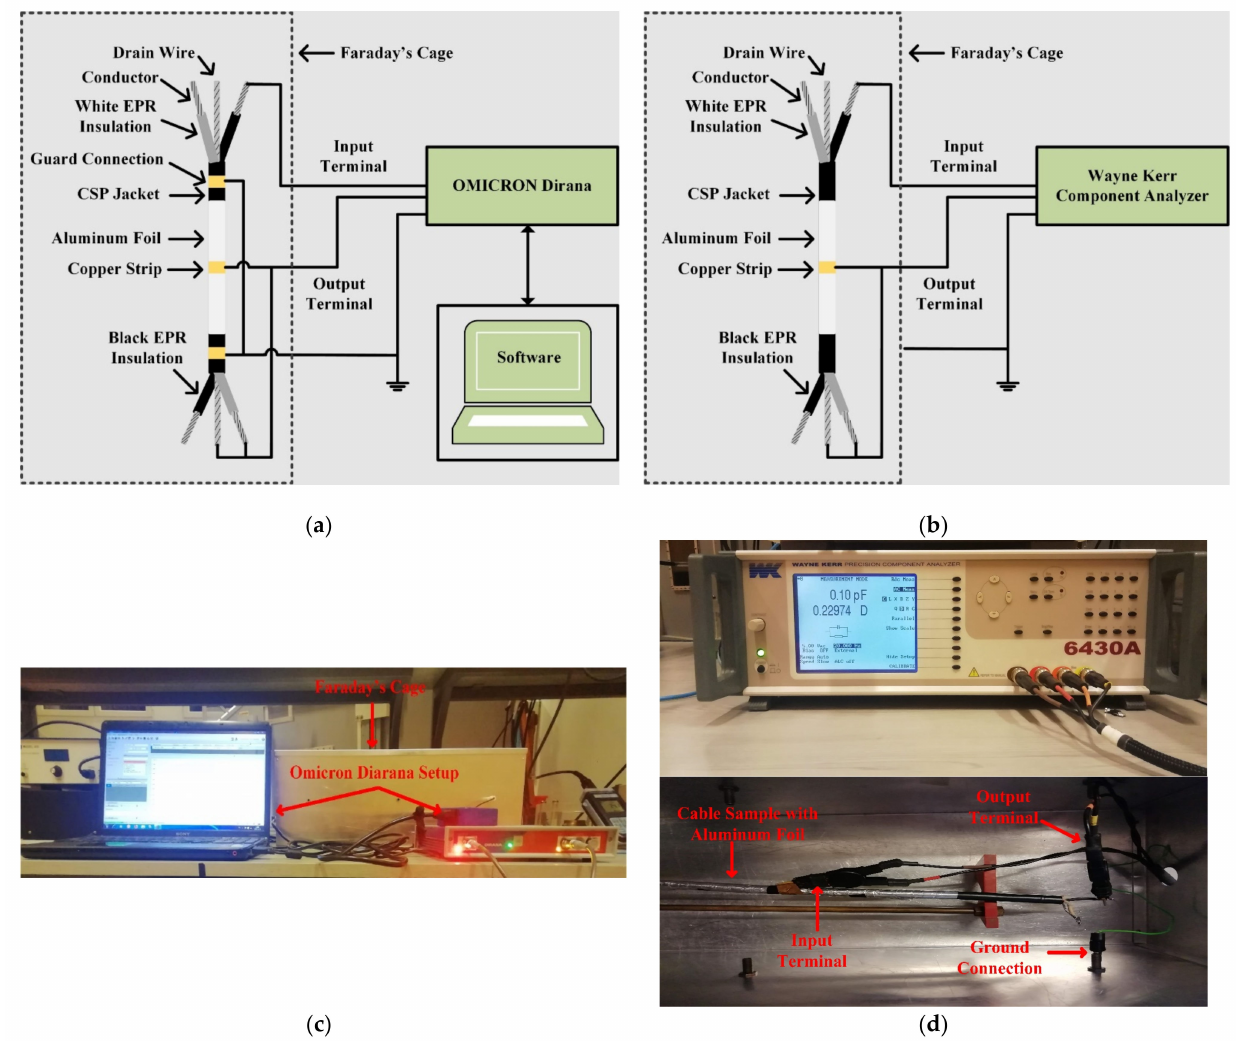
Figure 2. Connection diagram: ( a ) OMICRON Dirana, ( b ) Wayne Kerr Component Analyzer, and measurement setup, ( c ) OMICRON Dirana, and ( d ) Wayne Kerr Component Analyzer for capacitance and tan δ